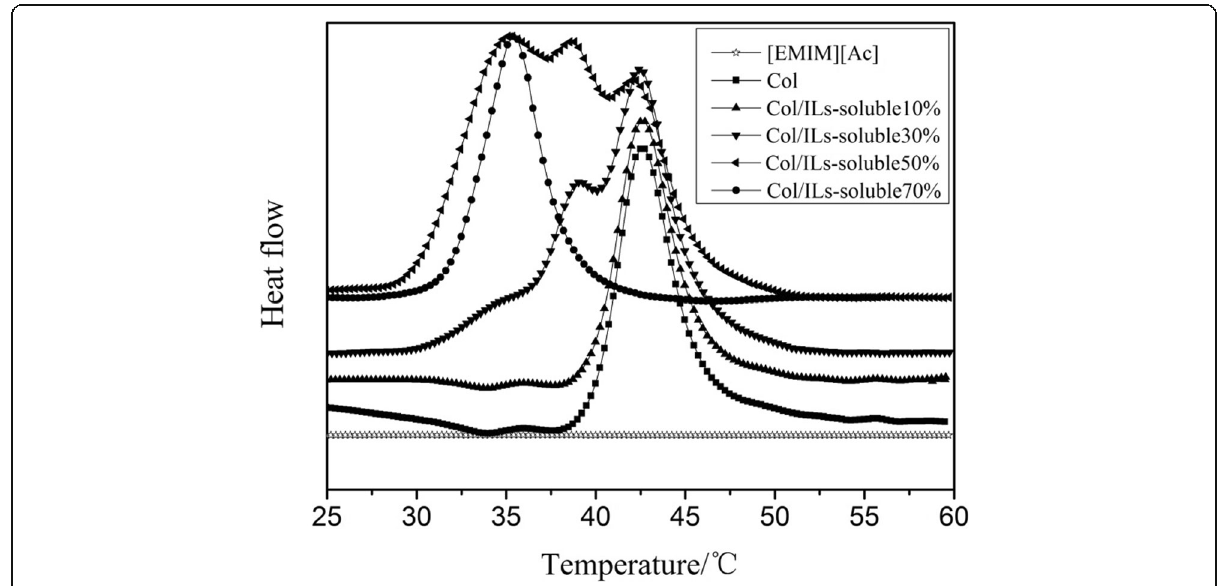
Fig. 6 US-DSC curves of Col, [EMIM][Ac] and collagen samples dissolved in different concentrations of [EMIM][Ac]